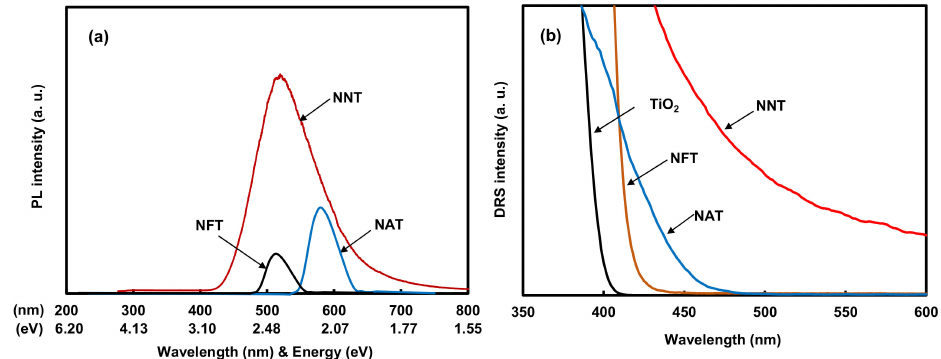
Figure 6. ( a ) PL spectra and ( b ) UV-visible DRS spectra of TiO 2 (P25) and metal ion-doped TiO 2